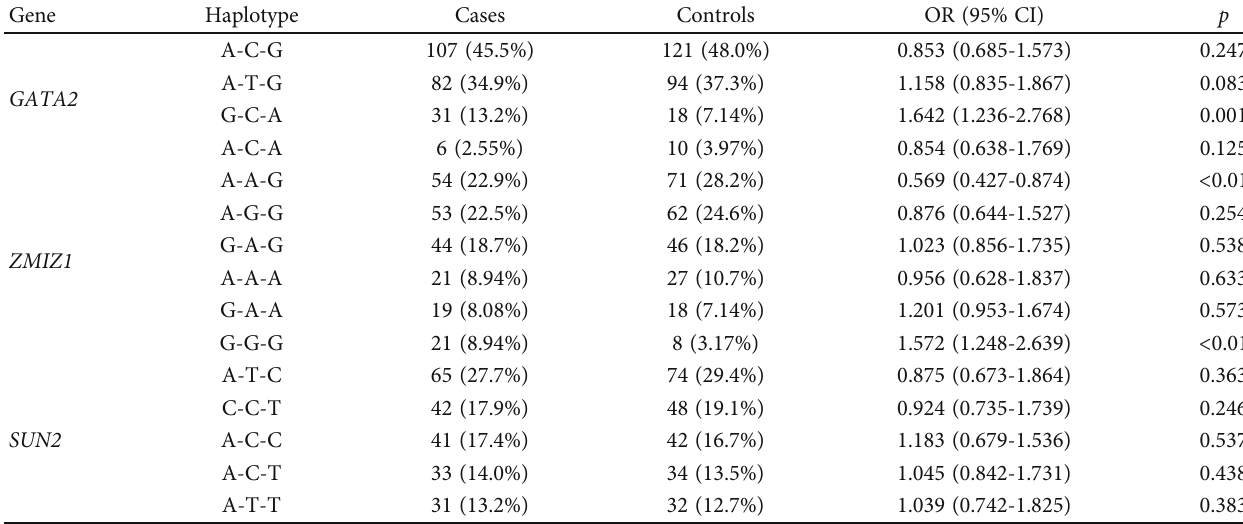
Table 4: Association between haplotypes of three candidate genes and PCa.